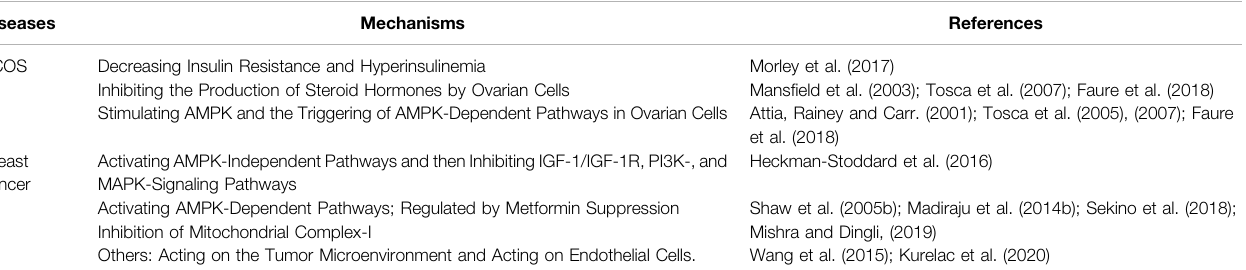
TABLE 7 | The effects and potential mechanisms of metformin on PCOS and breast